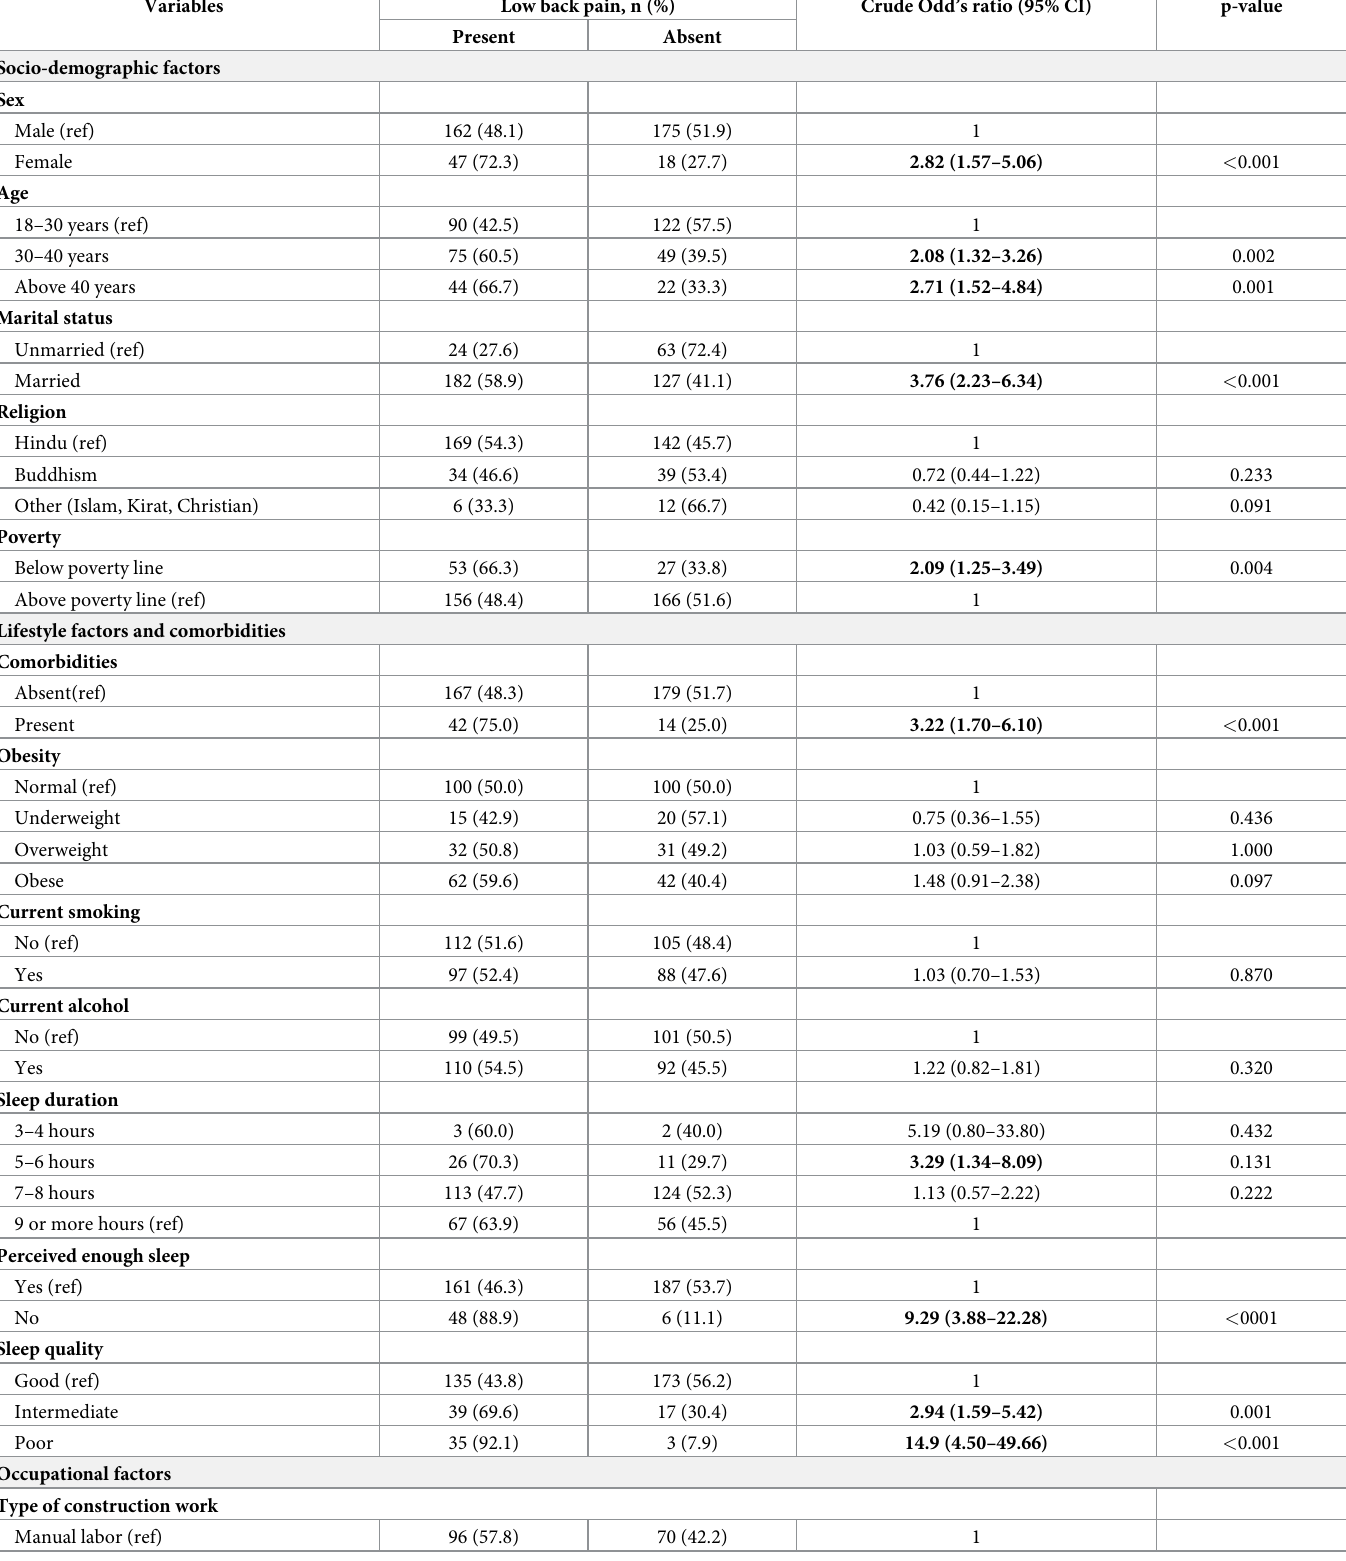
Table 3. Univariate logistic regression to determine association of socio-demographic, lifestyle, occupational and psychosocial factors with LBP (N = 402).